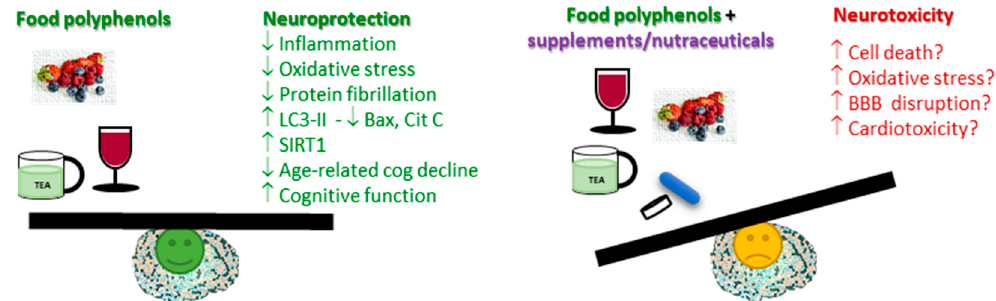
Figure 2. Summary of key mechanisms and actions from polyphenol neuroprotection, also highlighting possible safety concerns derived from polyphenol overconsumption.